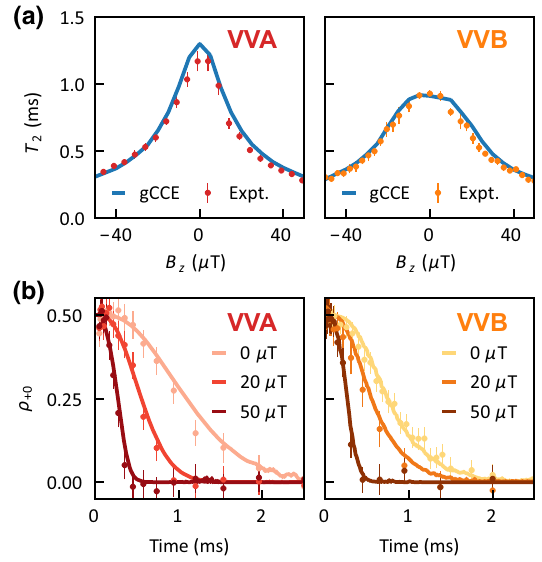
FIG. 4. Single defect Hahn-echo coherence time of the kh - V C V Si divacancy. (a) Distribution of T 2 for VVA (left) and VVB (right) as a function of the magnetic field B z (VVA and VVB are the same defects represented in Fig. 3). (b) The Hahn echo decay for three different values of the magnetic field. Solid lines correspond to theoretical predictions, points to experimental measurements. Error bars correspond to 2SD.